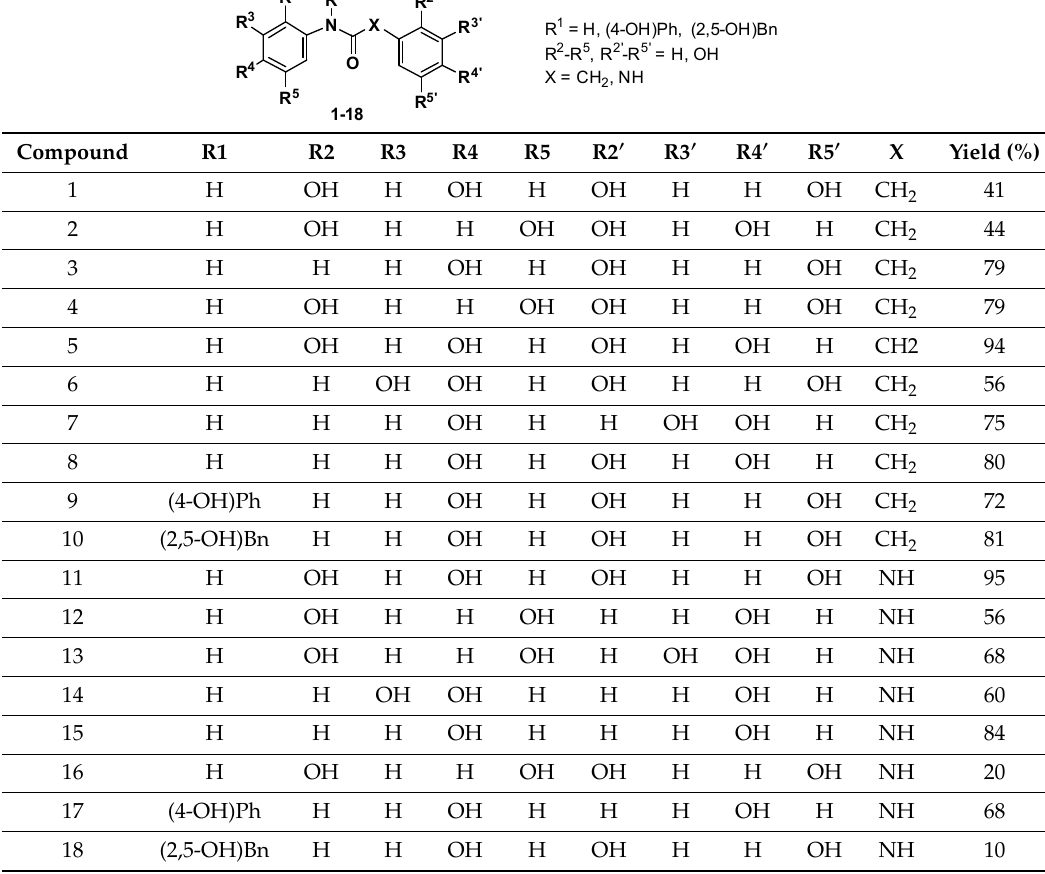
Table 1. Structures and yield of synthetic polyhydroxy amides ( 1 to 10 ), and ureas ( 11 to 18 ) prepared.